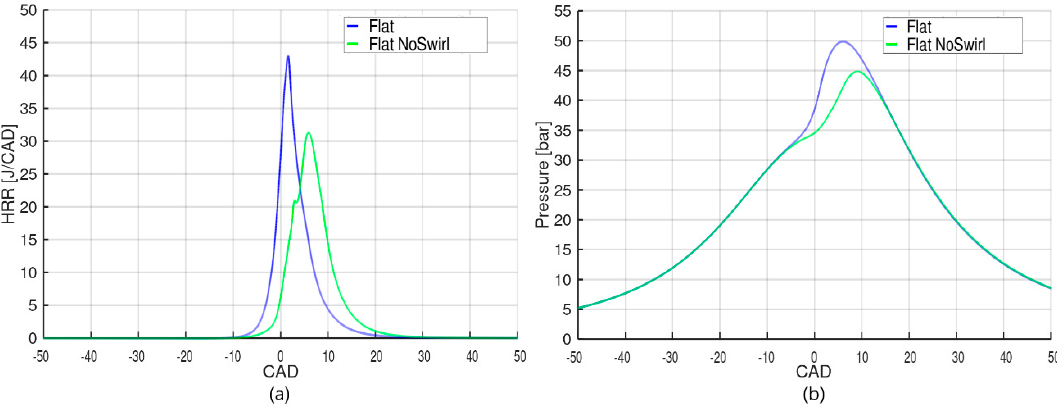
Figure 11. Results obtained for the two flat cases: ( a ) heat release rate; ( b ) in-cylinder pressure.